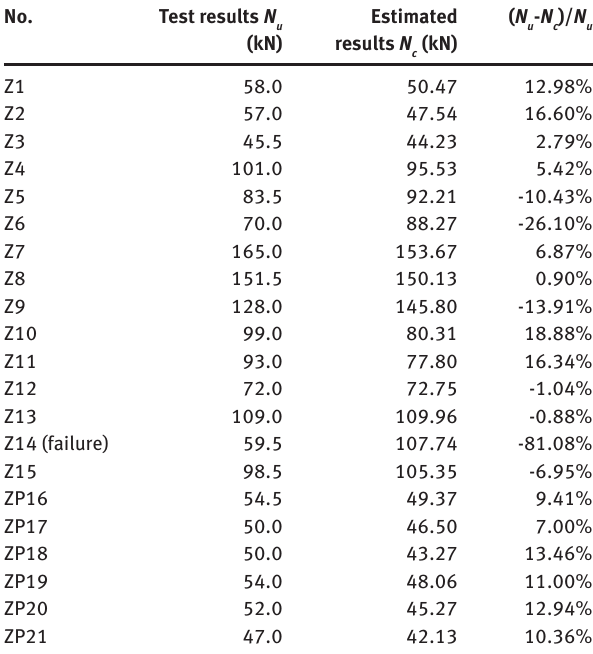
Table 2: Comparison of the estimated results and the test results.